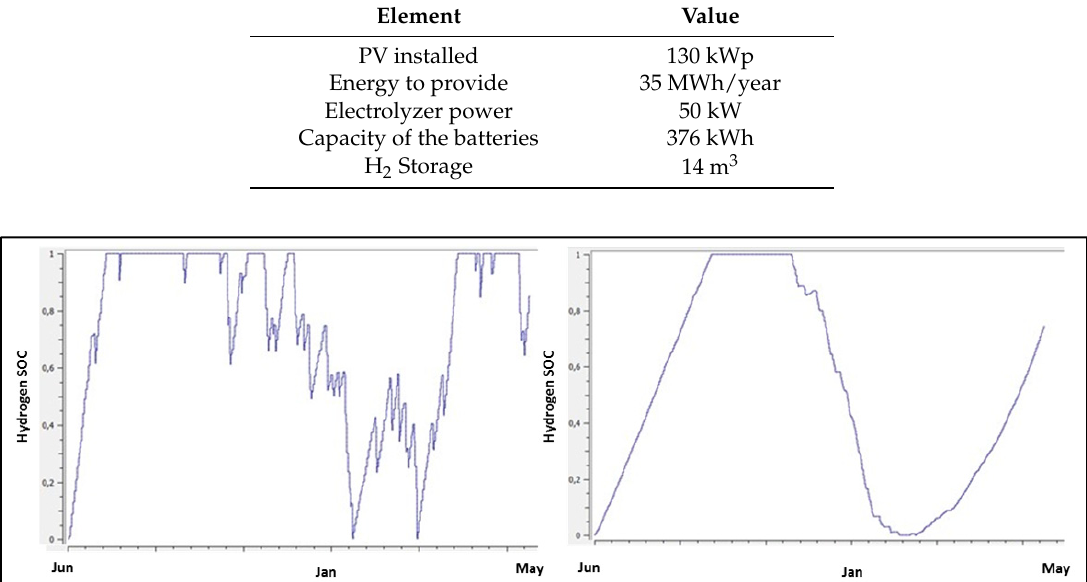
Figure 8. Evolution of H 2 state of charge in Tenerife and Edinburgh.